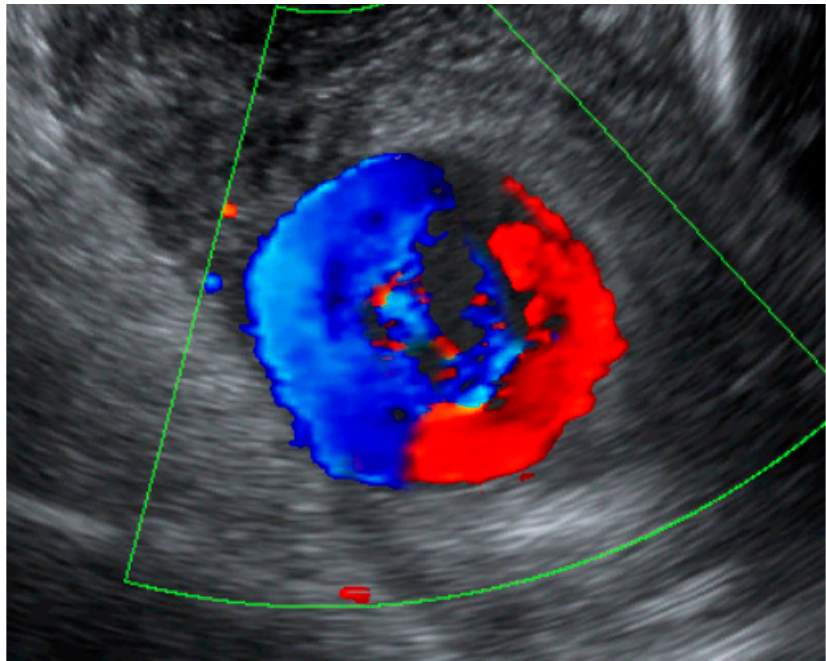
Figure 2. and Video S2 : A color flow ultrasound of the same mass as Figure 1 shows swirling flow in the mass, which is consistent with the arterial flow as presented in Figure 2 and video S2. A uterine artery aneurysm was diagnosed based on the finding of active swirling blood flow in the saccular-like sac connecting the uterine artery.